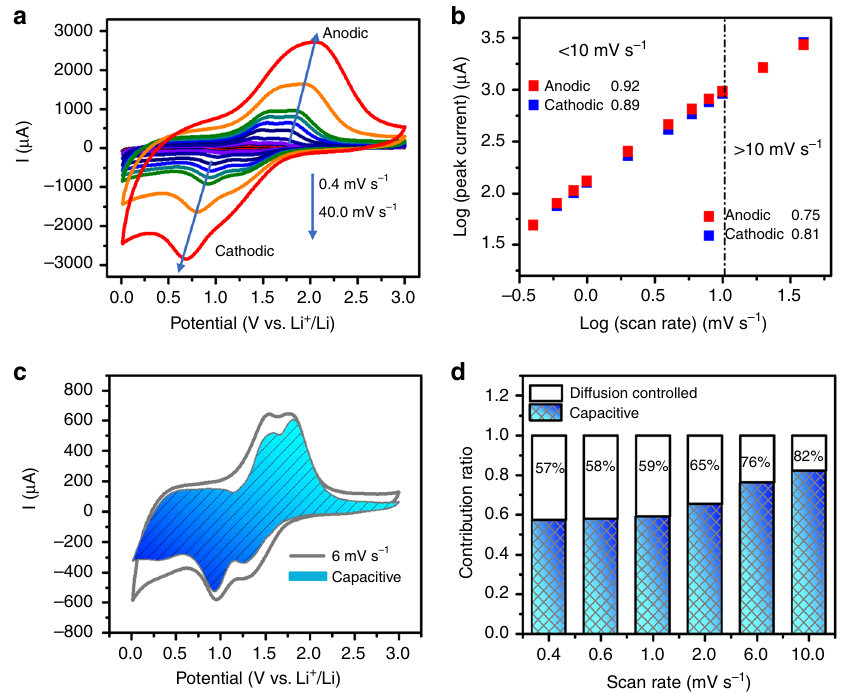
Fig. 3 Kinetic properties of LLTO. a CV curves at different scanning rates; b Corresponding peak current versus square root of scan rates; c Separation of the capacitive and diffusion currents at a scan rate of 6 mV s − 1 ; d The percentage of pseudocapacitive contribution at different scan capability. This kind of transition has previously found in other respectively, suggestive of a fast capacitive-controlled kinetics. A materials with pseudocapacitive nature, such as T-Nb 2 O 5 15 and G- distinct in fl ection point corresponding to the decrease in the b - TiO 2 -B 17 , which may be caused by the enhanced ohmic resistance values of 0.75 (anodic peak) and 0.81 (cathodic peak) at sweep or diffusion constraints. Moreover, the relationship between rates >10 mV s − 1 is found, indicative of the limitation to the rate